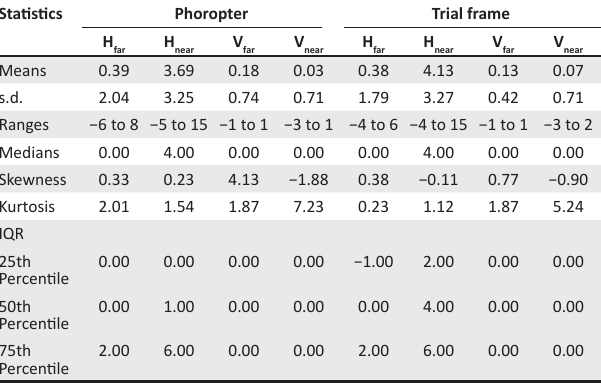
TABLE 2: Descriptive statistics for the heterophoria measurements using the phoropter and trial